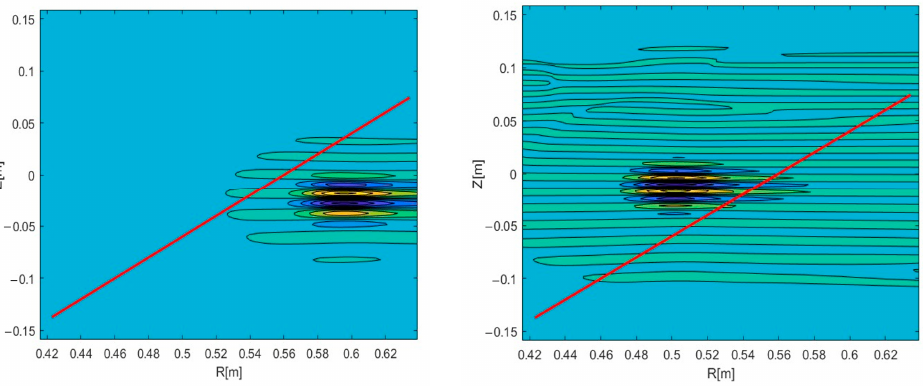
Figure 18. Two-dimensional DBS signal map for the circular filament positioned at the 48 GHz prob- ing frequency: ( left ) 39 GHz; ( right ) 55 GHz probing frequency. The red line indicates the trajectory.